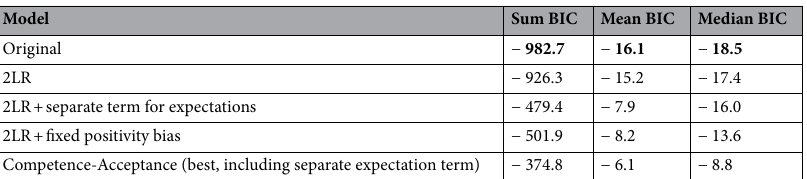
Table 2. Model comparison of baseline vs. two-learning-rate model for the discovery sample. The pattern of results was very similar for the test (subclinical) sample (see Supplement). The Bayesian Information Criterion (BIC) was used to compare the models, a lower BIC indicating a better fit 28 . Models were simultaneously fit to approval predictions and momentary self-esteem. BIC values of winning model are in